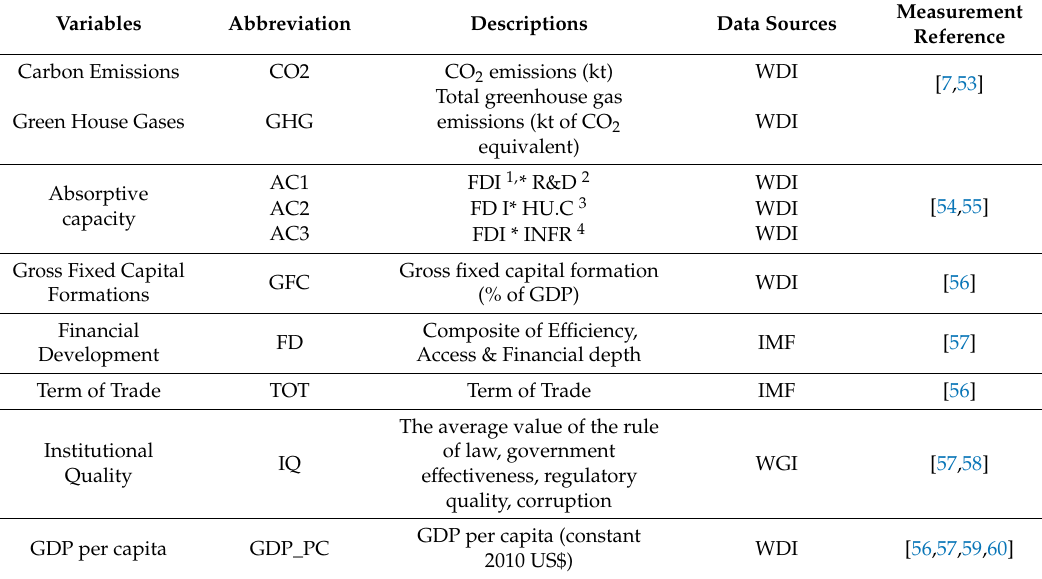
Table 1. Variables of the